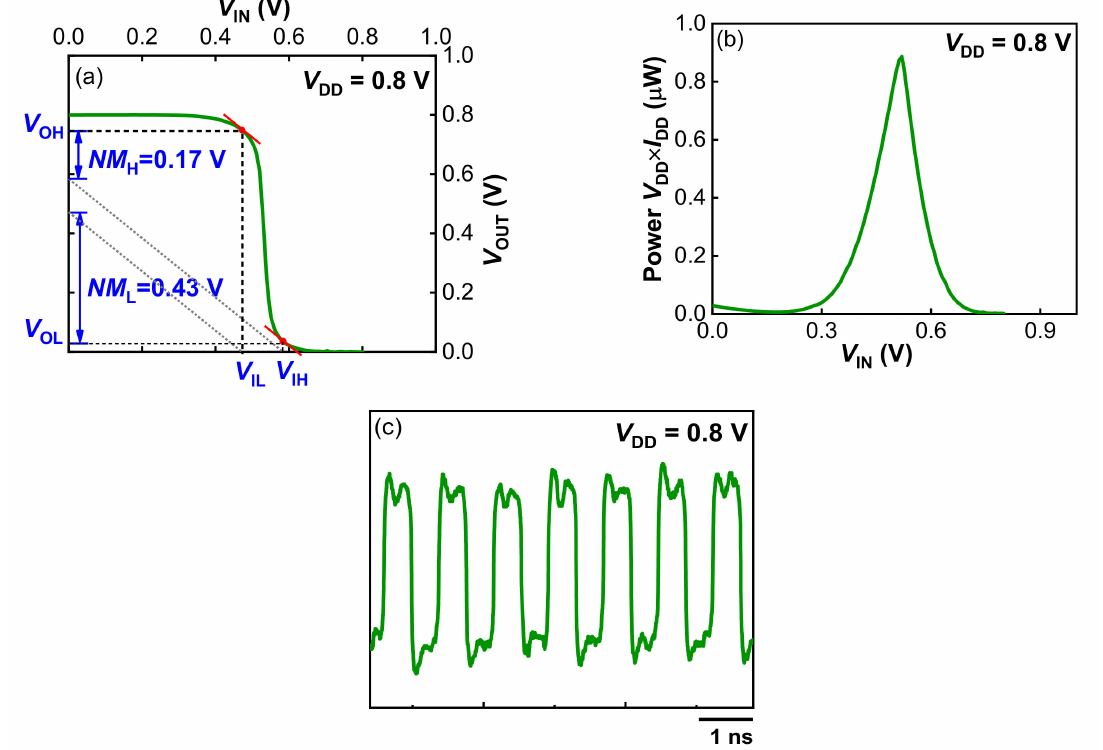
Figure 9. ( a ) Linear approximation of the VTC to estimate the static NMs, ( b ) Static power con- sumption with respect to V IN , ( c ) Characteristics of 101-stage CMOS RO based on low-temperature Schottky S/D